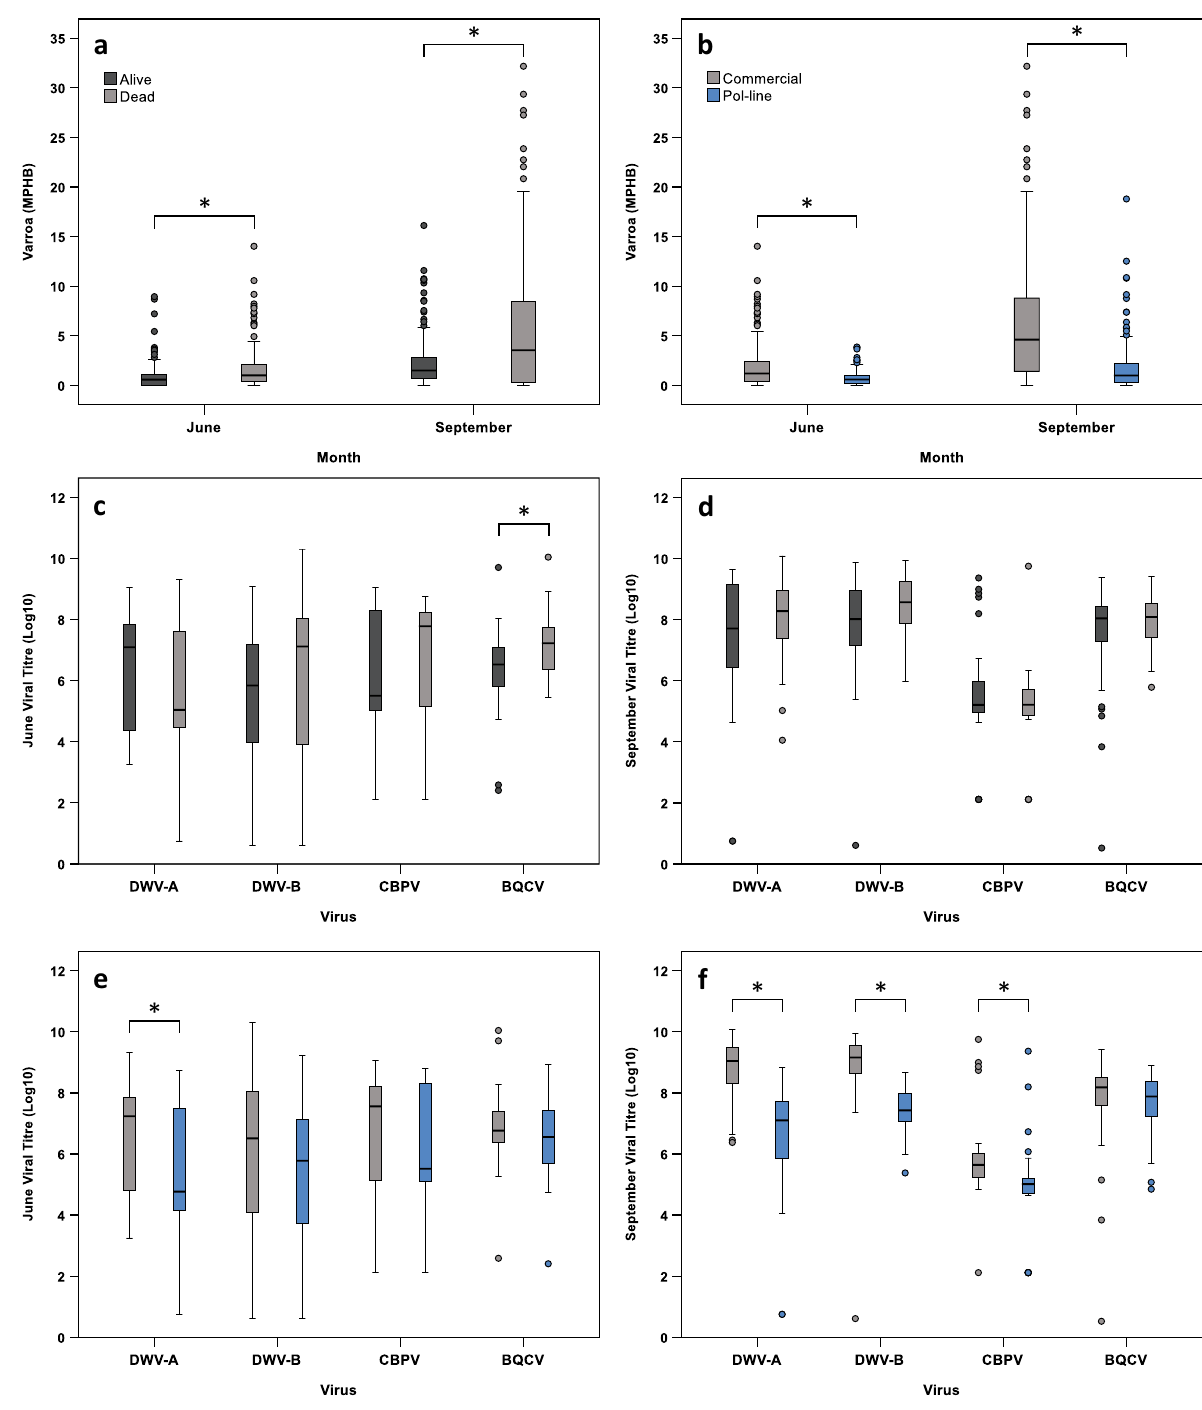
Figure 4. ( a , b ) June and September differences in Varroa levels (June, N Commercial = 190, N Pol-line = 167; September, N Commercial = 167, N Pol-line = 157). ( c – f ) June and September differences in viral titres (June, N Commercial = 46, N Pol-line = 42; September, N Commercial = 37, N Pol-line = 39). Boxplots are coloured based on survival outcome in February (survived, dark grey; died, light grey) ( a , c , d ), and stock (Commercial, grey; Pol-line, blue) ( b , e , f ). Outliers (greater than 1.5 times the interquartile range from the median) are indicated with circles. Asterisks indicate significant differences between groups (η 2 > 0.060, P <